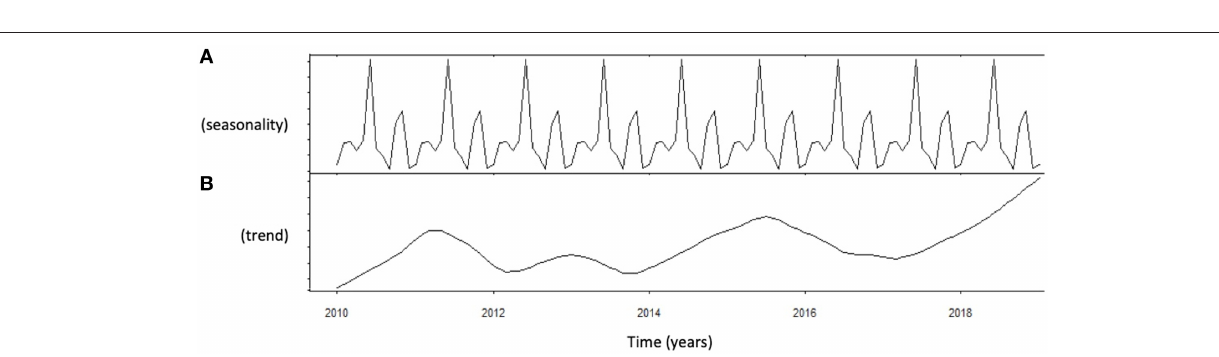
different distribution among the seasons ( p < 0.001), with